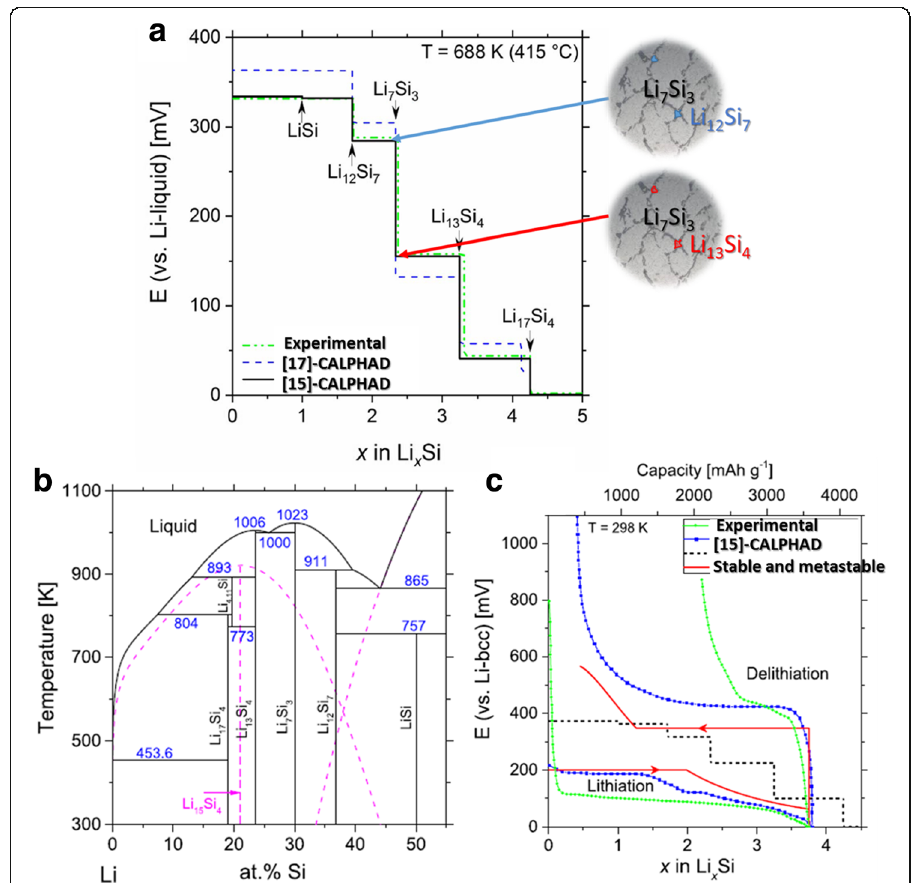
Fig. 6 Electrochemical potentials and phase diagram for the Li-Si system (Liang et al. 2017) (adapted with permission of the copyright holder); a electrochemical potential vs. Li-liquid at 688 K. The schematic photomicrographs were added to highlight the step- variation of the electrochemical potential of Li 7 Si 3 depending if Li 7 Si 3 is in equilibrium with Li 12 Si 7 or Li 13 Si 4 ; μ phase − μ 0 ; liq μ 0 ; liq ¼ − zF Δ V ; Δ V ¼ E ð vs : Li − liquid Þ½ mV (cid:2) ; b assessed phase diagram using the CALPHAD method; c Li electrochemical potential vs. Li-bcc (solid) at 298 K. μ phase − μ 0 ; bcc Li − bcc Þ½ mV (cid:2) . phase ∈ { LiSi , Li 12 Si 7 , Li 7 Si 3 , Li 13 Si 4 , Li 17 Si 4